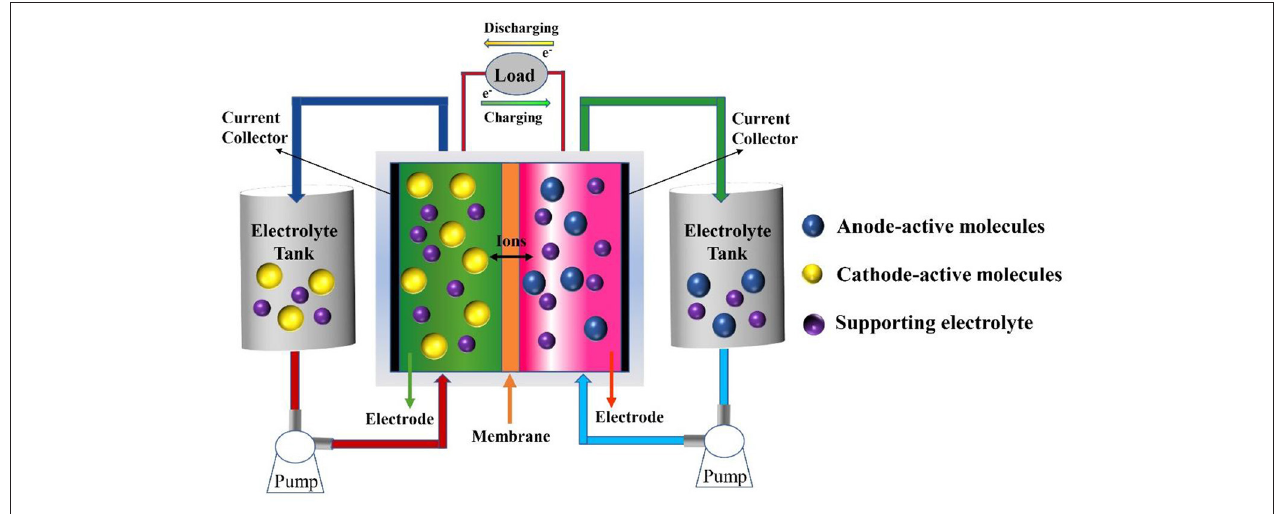
FIGURE 1 | Schematic illustration of a typical redox flow